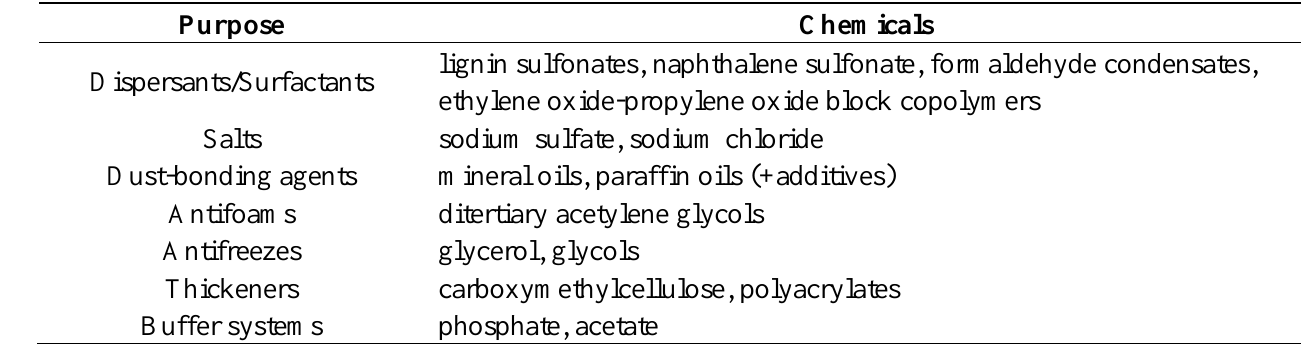
Table 1. Ingredients used in a dyestuff formulation